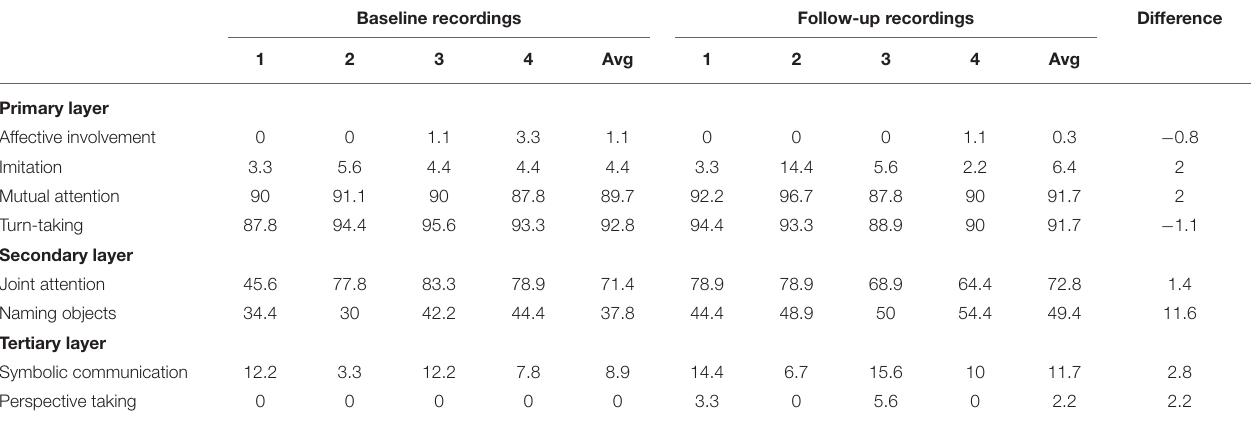
TABLE 7 | Percentage presence of LCM behaviors and difference in presence between baseline and follow-up recordings for dyad 5. Baseline